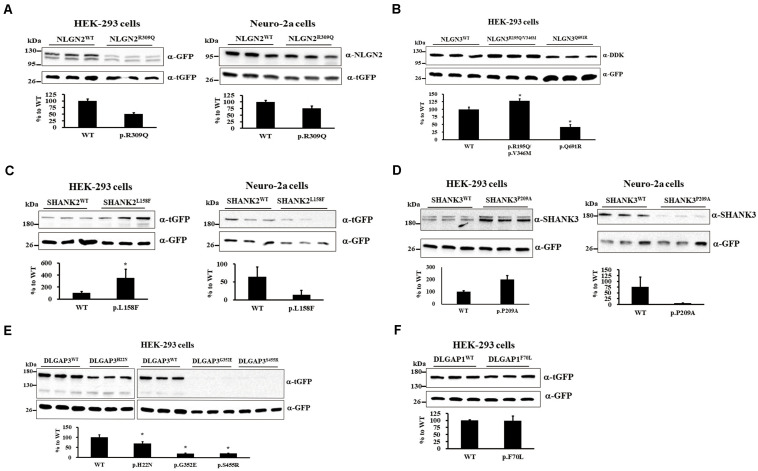
Immunoblotting of gene mutants in cultured cells. (A) Immunoblotting of protein extracts from HEK-293 cells (left) and neuro-2a cells (right) transiently cotransfected with a plasmid expressing either NLGN2WT or NLGN2R309Q cDNAs with pCMV6-AC-tGFP. (B) Immunoblotting of protein extracts from HEK-293 cells transiently cotransfected with a plasmid expressing NLGN3WT, NLGN3R195Q/V346M, or NLGN3Q691R cDNAs with pcDNA3.1-GFP. (C) Immunoblotting of protein extracts from HEK-293 cells (left) and neuro-2a cells (right) transiently cotransfected with a plasmid expressing either SHANK2WT or SHANK2L158F cDNAs with pcDNA3.1-GFP. (D) Immunoblotting of protein extracts from HEK-293 cells (left) and neuro-2a cells (right) transiently cotransfected with a plasmid expressing either SHANK3WT or SHANK3P209A cDNAs with pcDNA3.1-GFP. (E) Immunoblotting of protein extracts from HEK-293 cells transiently cotransfected with a plasmid expressing DLGAP3WT or DLGAP3 mutant cDNAs (DLGAP3H22N, DLGAP3G352E, and DLGAP3S455R) with pcDNA3.1-GFP. (F) Immunoblotting of protein extracts from HEK-293 cells transiently cotransfected with a plasmid expressing either DLGAP1WT or DLGAP1F70L cDNAs with pCMV6-AC-GFP. For normalization, lysates were analyzed in parallel by anti-tGFP or anti-GFP immunoblotting. Results are representative of three independent experiments. WT, wild-type. Graphs represent means ± standard errors. *p < 0.05.